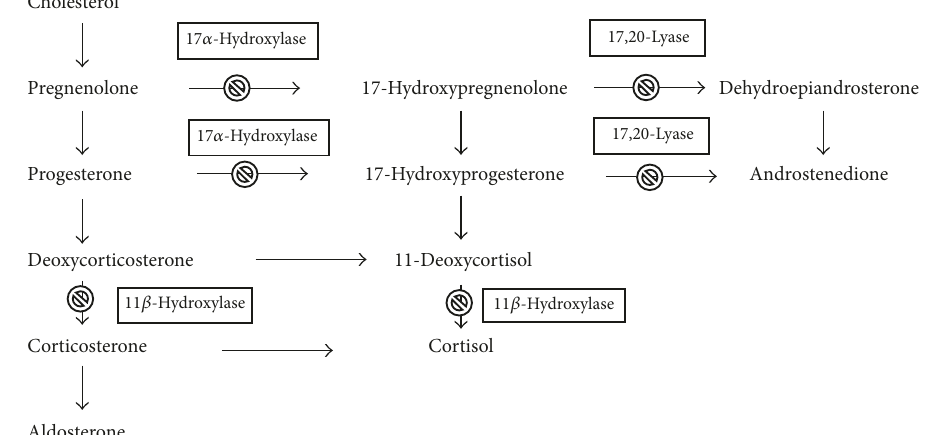
Figure 1: Diagram of the steroid synthesis pathway showing the steps where ketoconazole inhibits